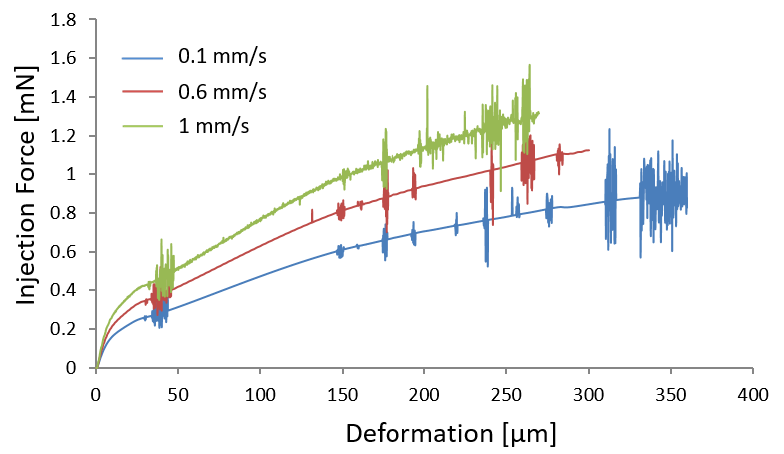
Figure 15. Comparison of the FE results for three injection speeds (0.1, 0.6, 1